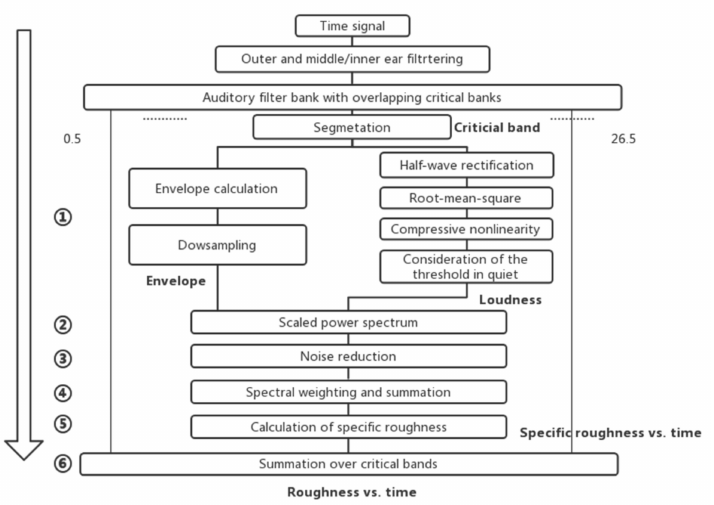
Figure 6. Flow chart for roughness index